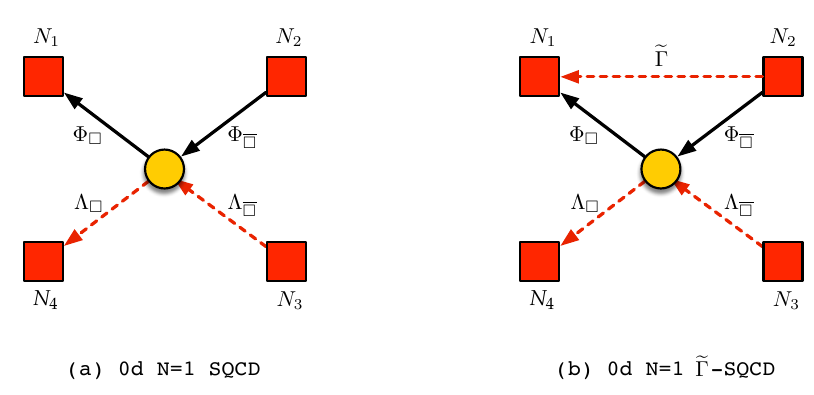
Figure 3 . Quiver diagrams of two di(cid:11)erent 0 d